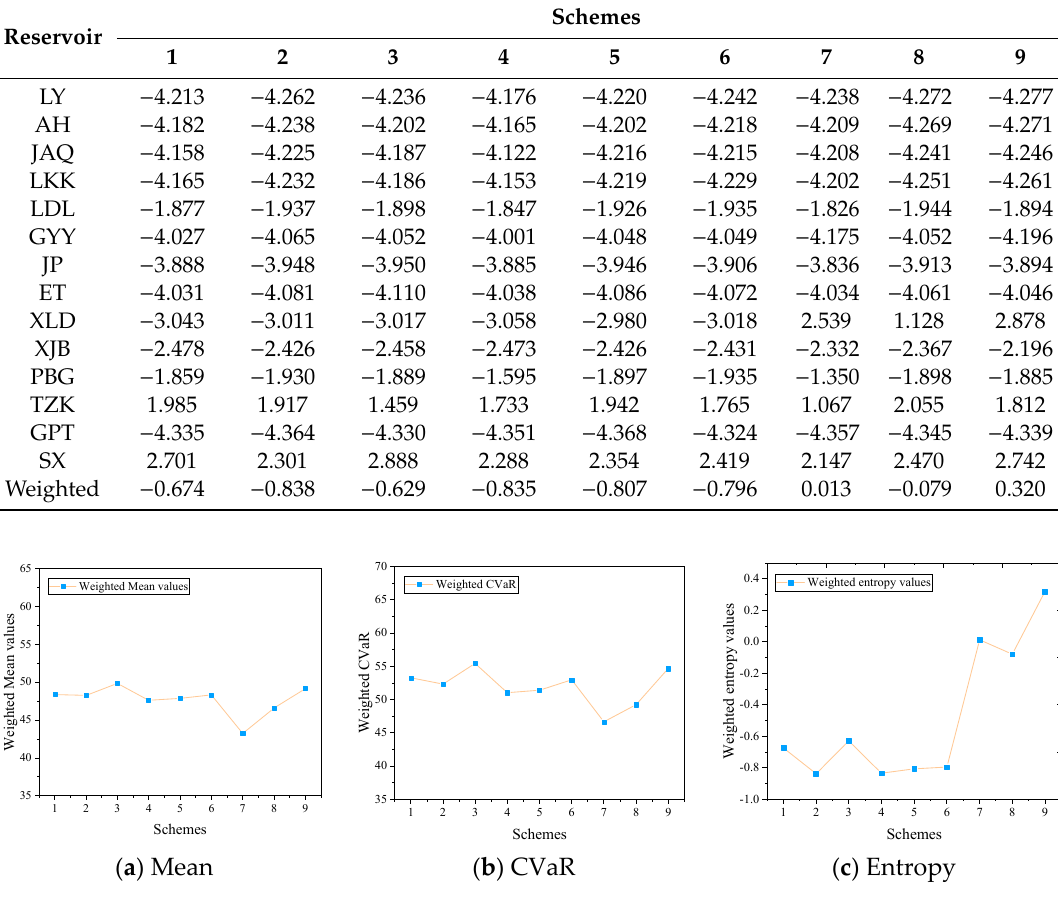
Table 5. The entropy values of the maximum occupied capacity of each reservoir under the operation of different schemes.